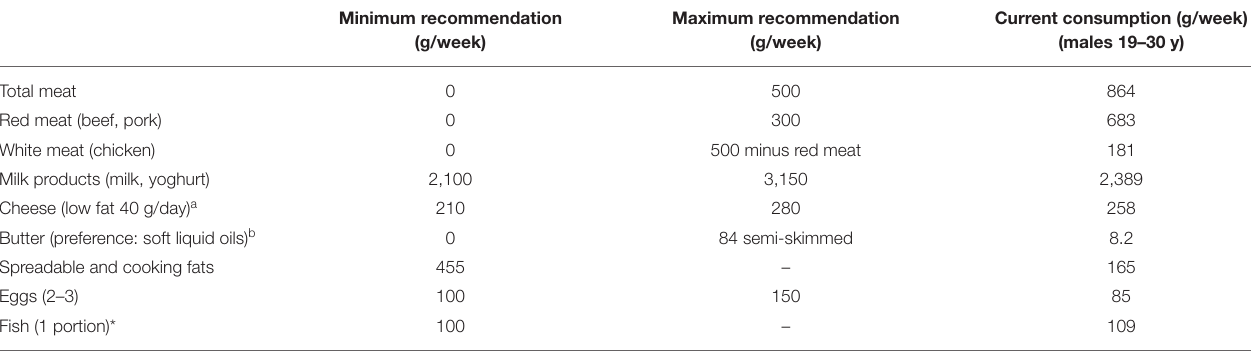
TABLE 2 | Recommended intake of animal products (g/mL) for adults per week in The Netherlands (36) and the current consumption of males 19–30 years old (27) in g/week.